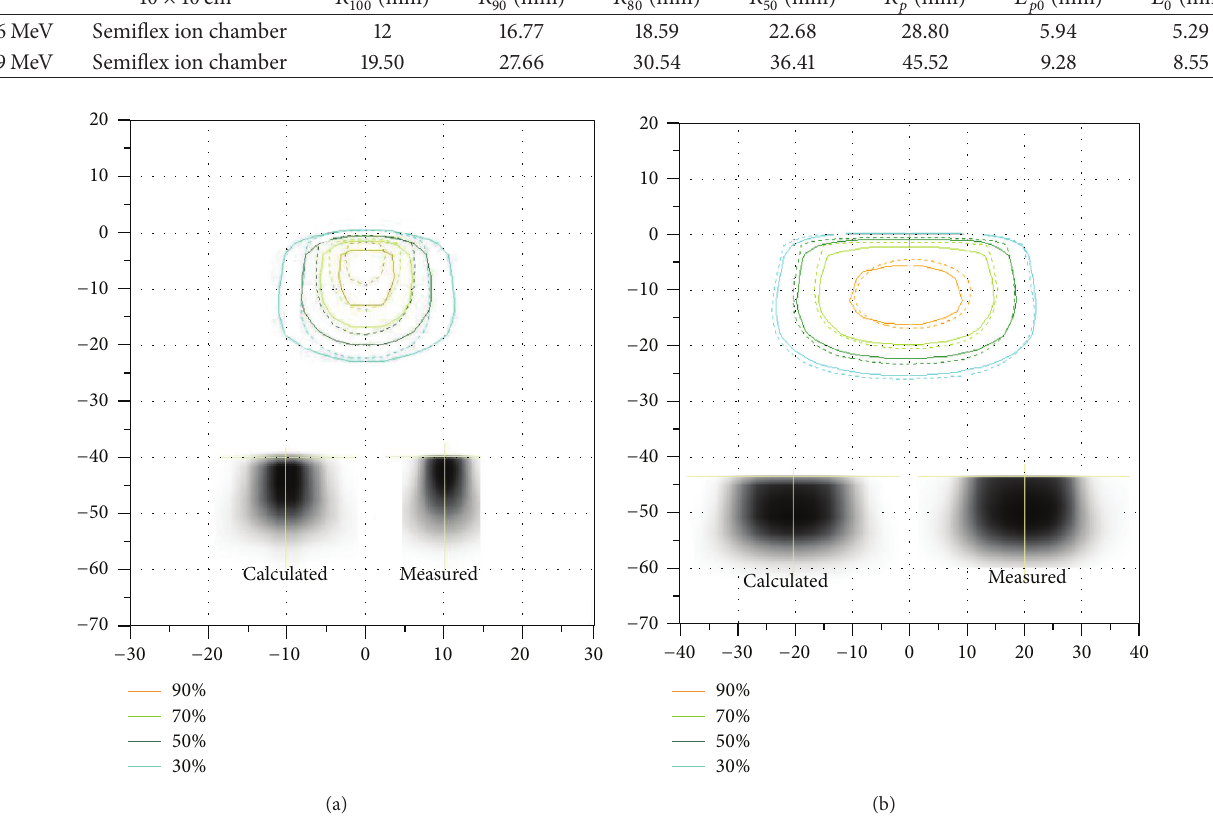
Figure 4: Sagittal isodose comparisons of a 6 MeV beam along the central axis for 1 (a) cm and 4 (b) cm circular cutouts using a 5cm diameter circular cone. Solid lines represent calculations and dotted lines represent measurements ( 𝑥 -axis and 𝑦 -axis are in